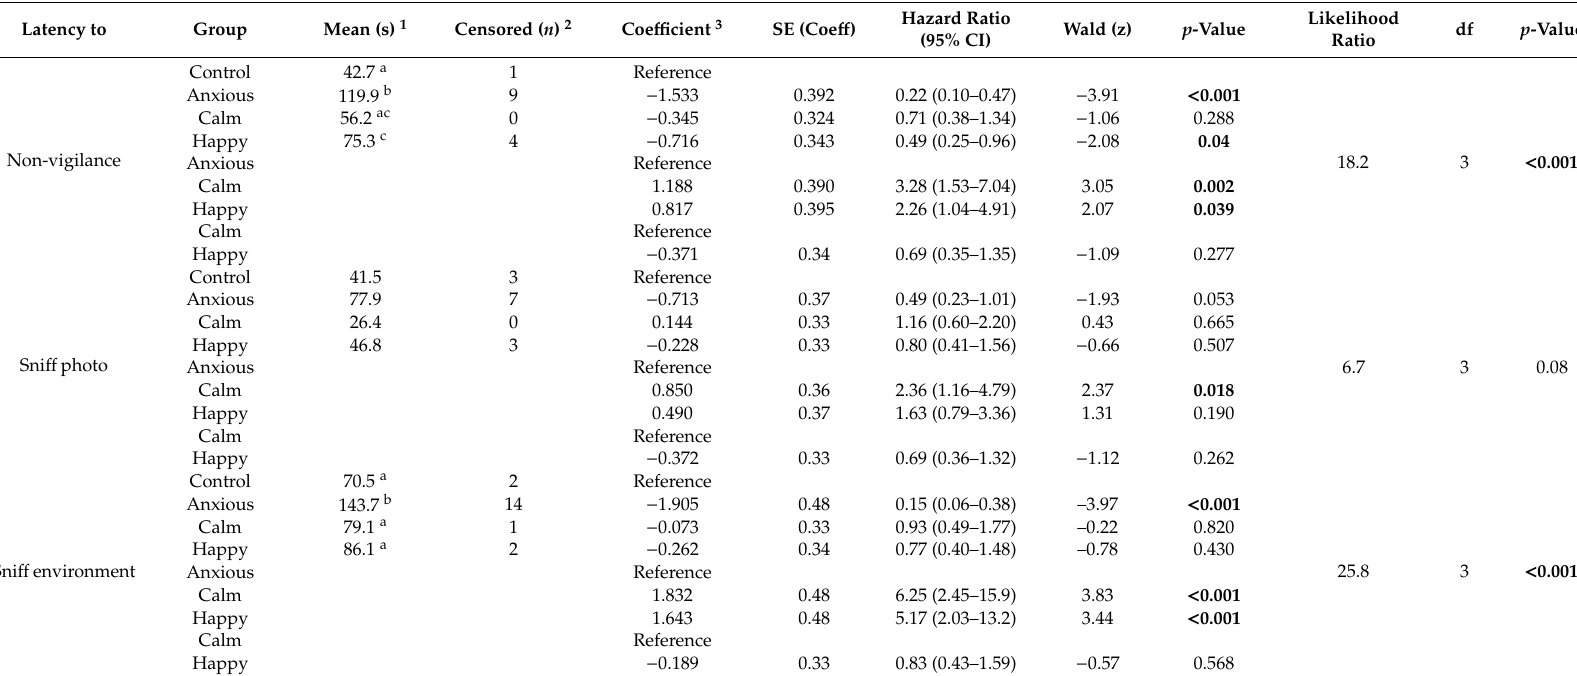
Table 3. Output of the Cox proportional-hazards models for latency to become non-vigilant, sni ff the photo and sni ff the